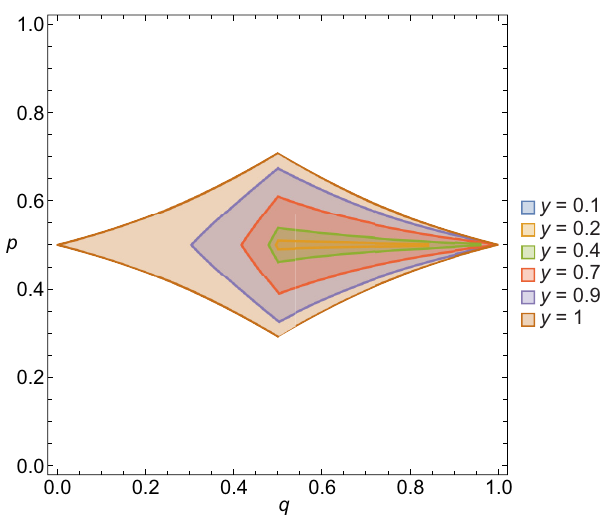
FIG. 7. The p , q region where Alice observe a violation > 1 for different values of y . (cid:2) A (cid:2) G (cid:17) ( p , q ) This shows that, for tensors in the positive direction (σ ) , for parameter values , σ , σ X Y Z